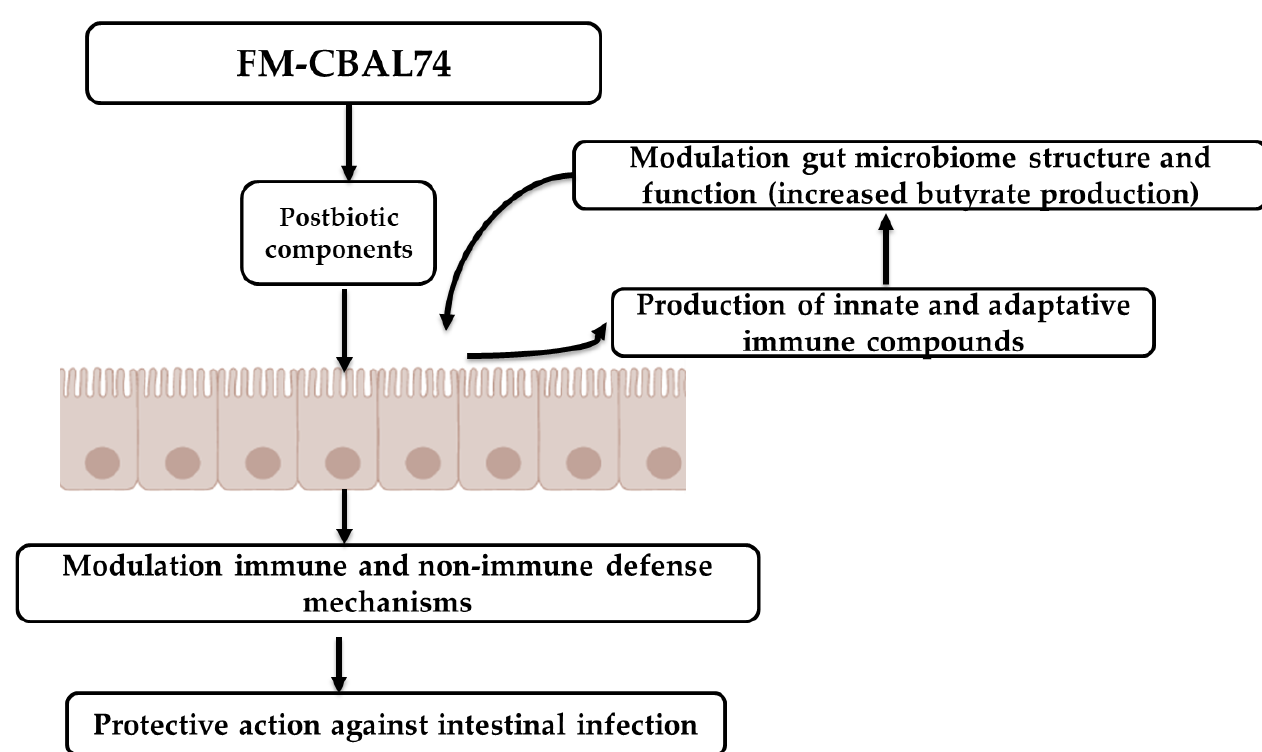
Figure 7. FM-CBAL74 modulates different defense mechanisms at intestinal level. The available literature suggests the potential role of dietary supplementation with FM-CBAL74 for the prevention of pediatric intestinal infections. The effects could be related to the activity of several components, including bacterial DNA and cell membrane components (e.g., peptidoglycans, polysaccharides, and lipoteichoic acid), as well as bacterial produced products during the fermentation, such as peptides and metabolites (e.g., lactic acid and other organic acids).